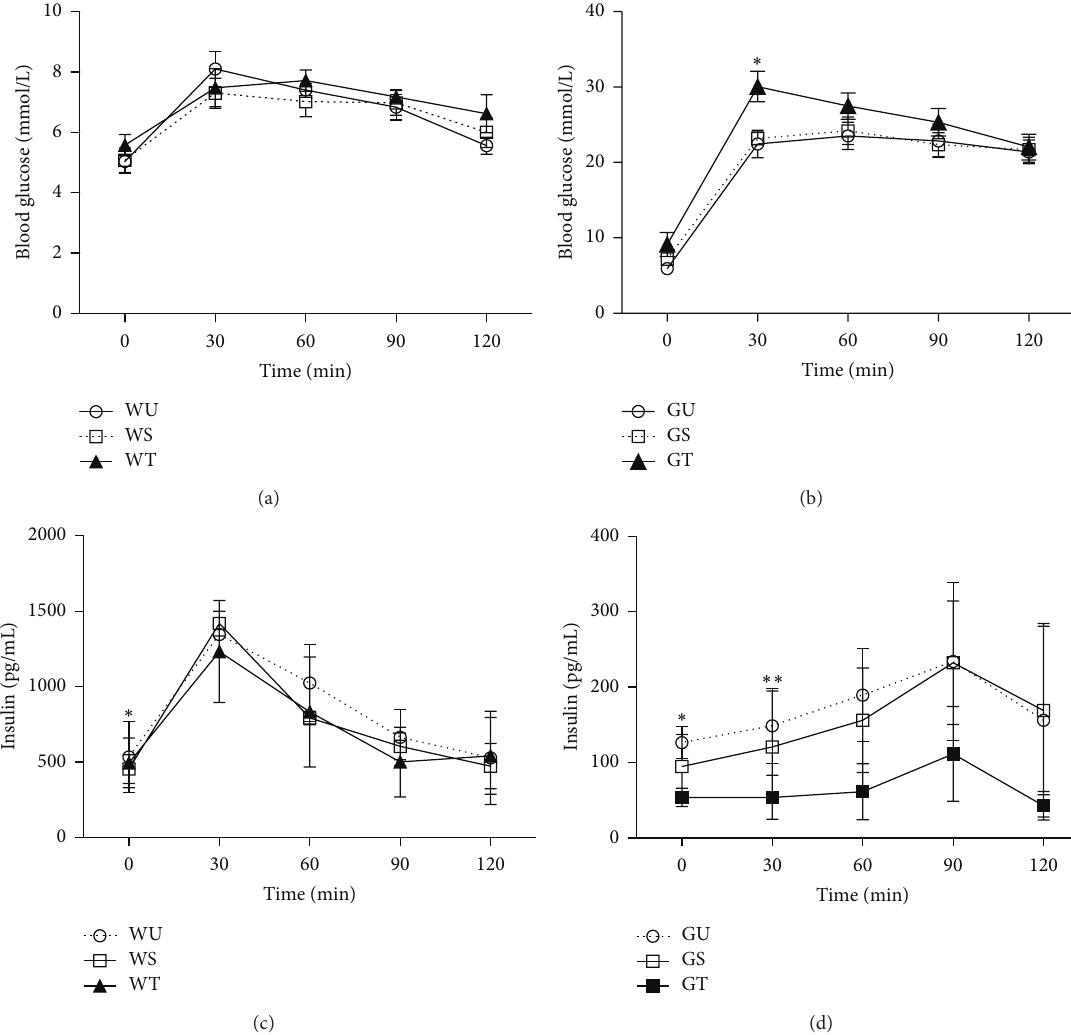
Figure 1: Transplanted PSCs impair glucose tolerance and 𝛽 -cell function in vivo . PSC-treatment had no effects on glucose clearance after oral glucose loading (a) or on glucose-stimulated insulin secretion (c) in Wistar rats. However, in contrast, PSC transplantation exacerbated the impaired glucose tolerance of GK rats (b), and the reduced levels of insulin secretion observed in control GK rats (d) were further suppressed by intrapancreatic transplantation of PSCs. All data were expressed as mean ± SE ( 𝑛 = 5 ). ∗ 𝑃 < 0.05 , ∗∗ 𝑃 < 0.01 versus untreated